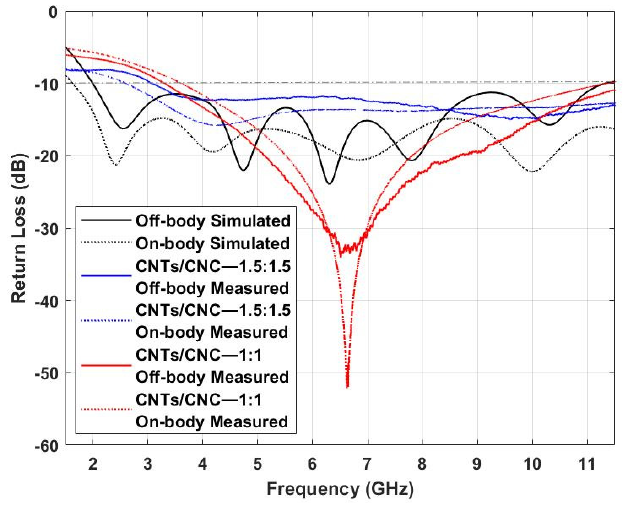
Figure 12. Simulated vs. Measured S 11 of CNTs/CNC PICA antennas in off- and on-body settings.